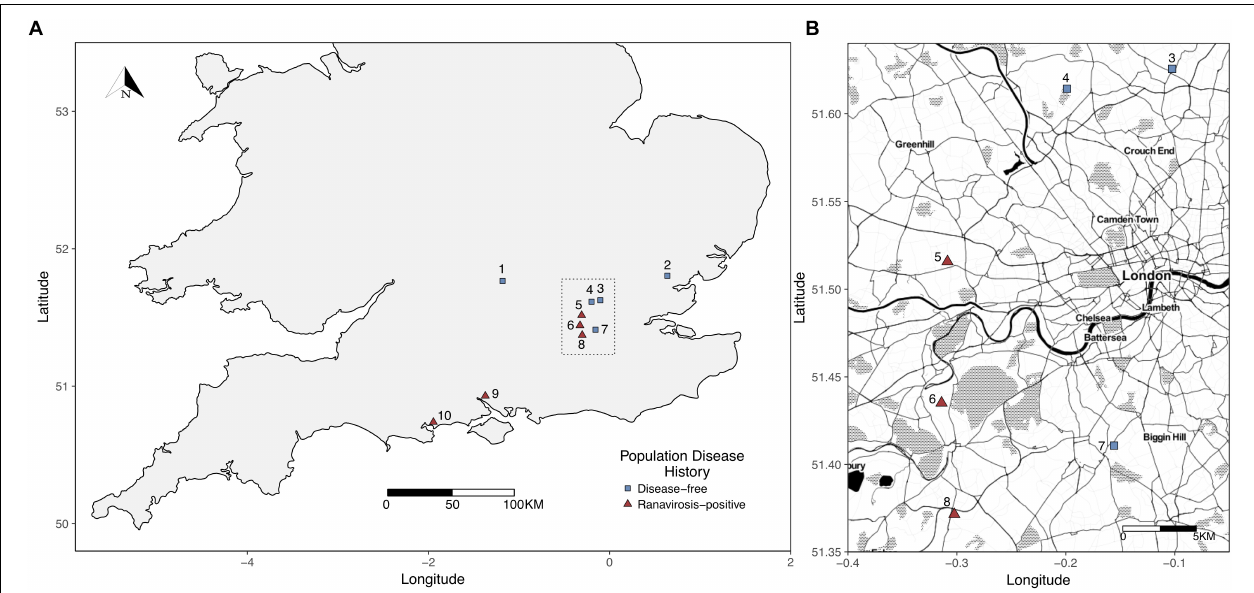
FIGURE 1 | (A) Map of sampled populations within the southern United Kingdom. To minimize potential environmental bias, differential abundance analysis, and indicator species analyses were restricted to those populations within the Greater London (area outlined by the dotted black box). (B) Closer scale map of populations within Greater London used for differential abundance and indicator species analysis. Populations = 1 – Oxford; 2 – Witham; 3 – Palmer’s Green; 4 – Folkington Corner; 5 – Ealing; 6 – Chessington; 7 – Mitcham; 8 –